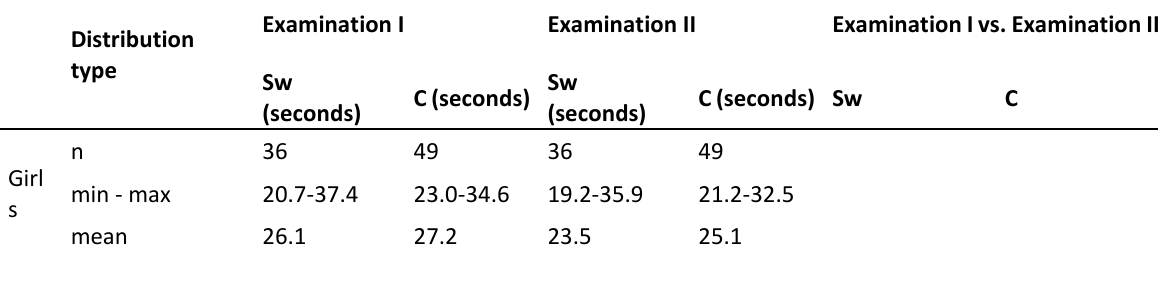
Control (C) group